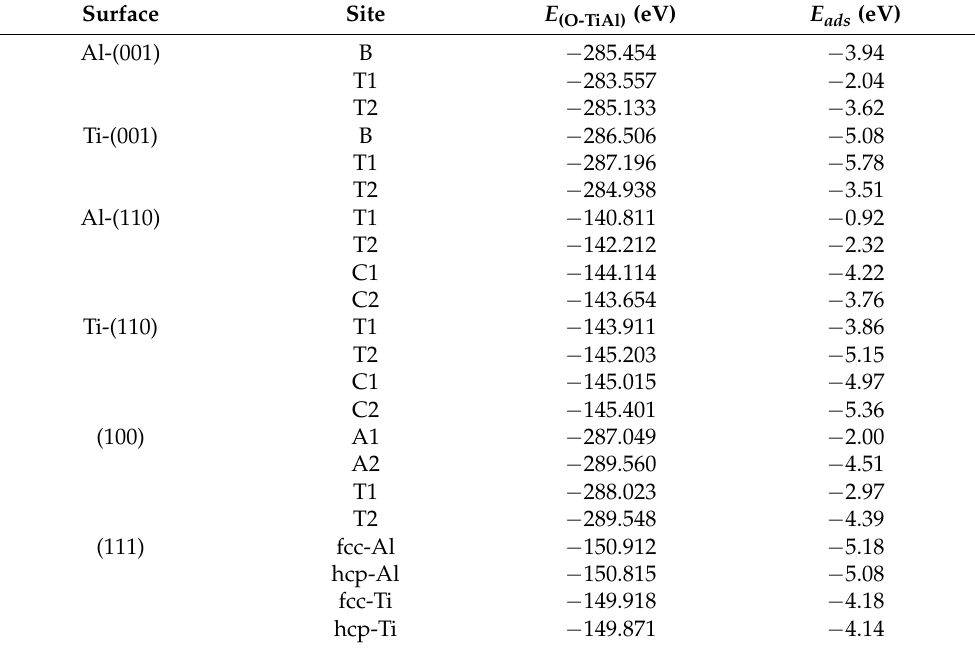
Table 1. Adsorption energy of an oxygen atom on the considered surfaces. (For (001) and (110) surfaces, B, T, and C stand for bridge site, top site, and center site, respectively. On the (100) surface, the oxygen atoms are on top of the Al and Ti atoms in the topmost (A1 and T1) and second (A2 and T2)